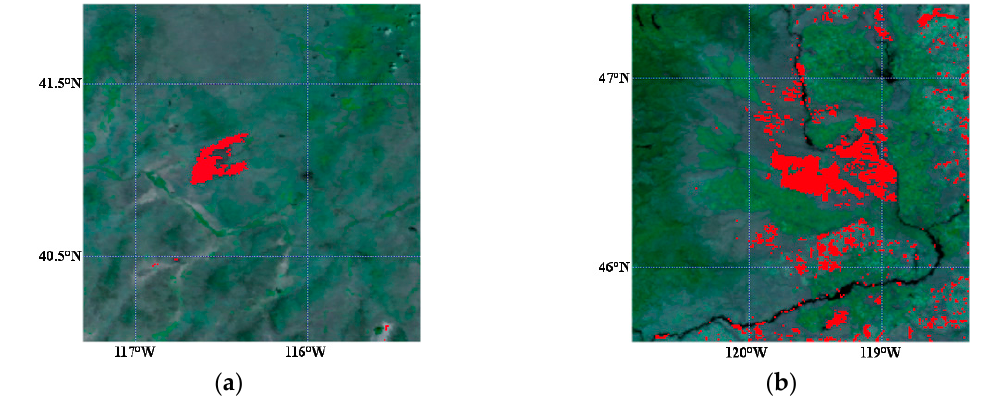
Figure 9. Results of burned area detection by the traditional empirical formula method. ( a ) Detected burned area in Hot Pot Fire; ( b ) detected burned area in Range 12